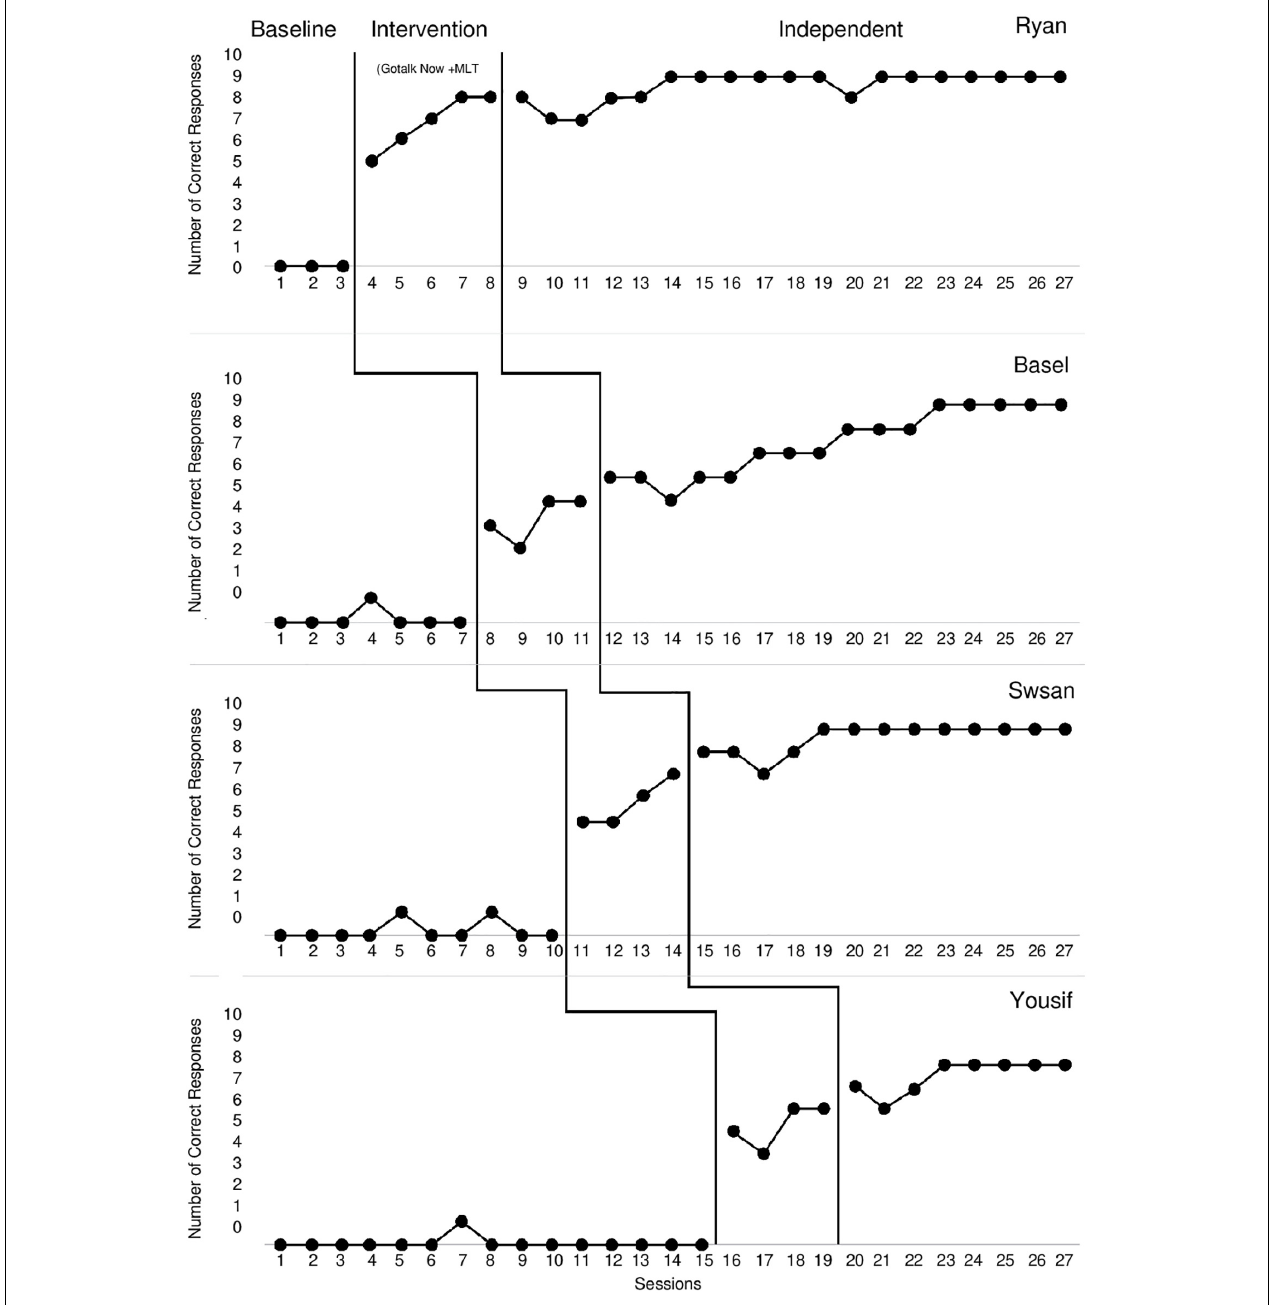
FIGURE 1 | The number of correct requests by each participant on the iPad for the baseline, intervention (MLT technique paired with the GoTalk NOW app), and (independent use of the GoTalk NOW app)